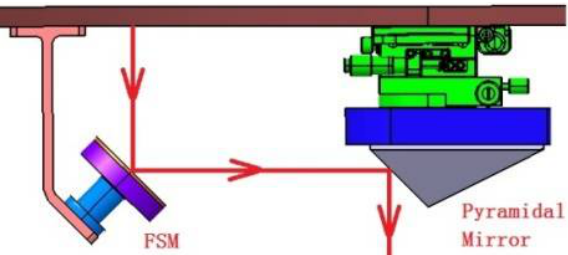
Figure 9. Three-dimensional model of the beam steering and adjustment structure.